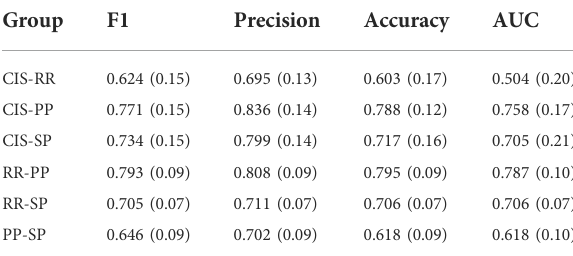
TABLE 5 Ablation study: Mean (st.dev) of the predictive performances oftheSVMmodelacrossthetenfoldsofthecrossvalidationusing FSAverage atlas.